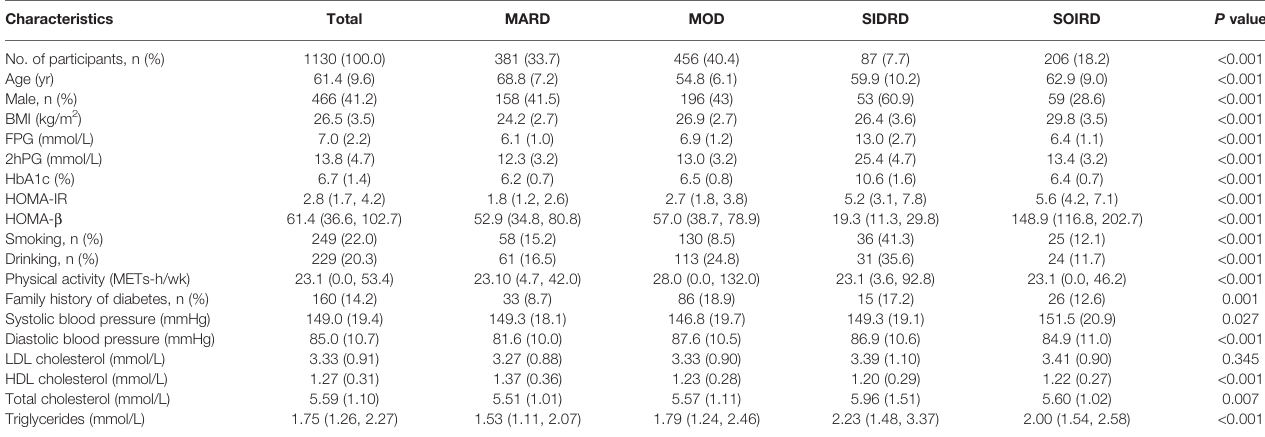
TABLE 1 | Patients ’ characteristics at baseline among the 4 clusters. Characteristics